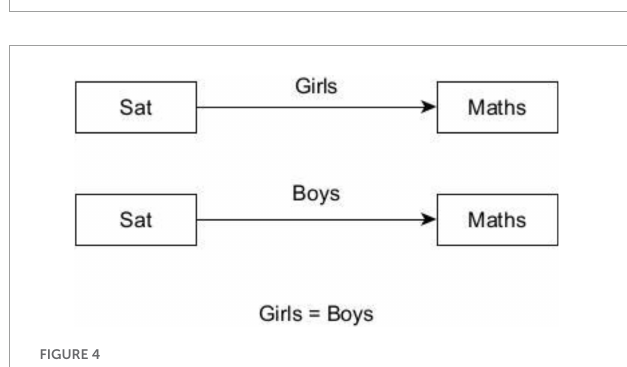
FIGURE3 Conceptual model of the potential moderating effect of gender on the relationship between satisfaction with life and mathematics achievement. Sat, satisfaction with life; Maths, mathematics achievement.